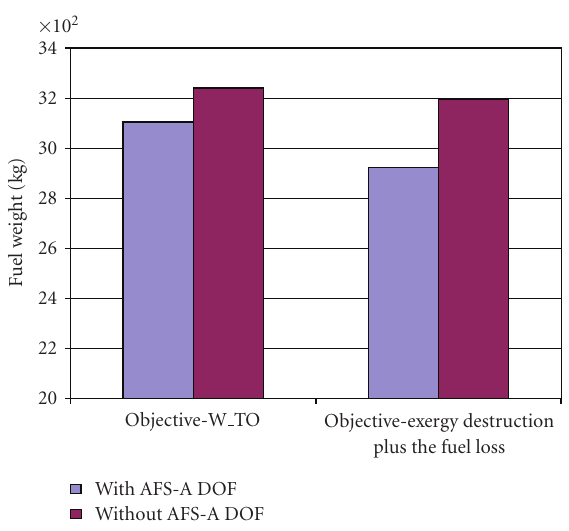
Figure 2: E ff ect of optimization metric on a generic high-speed fighter as fuel weight. Minimizing exergy destruction directly yields a design with improved fuel consumption (less fuel